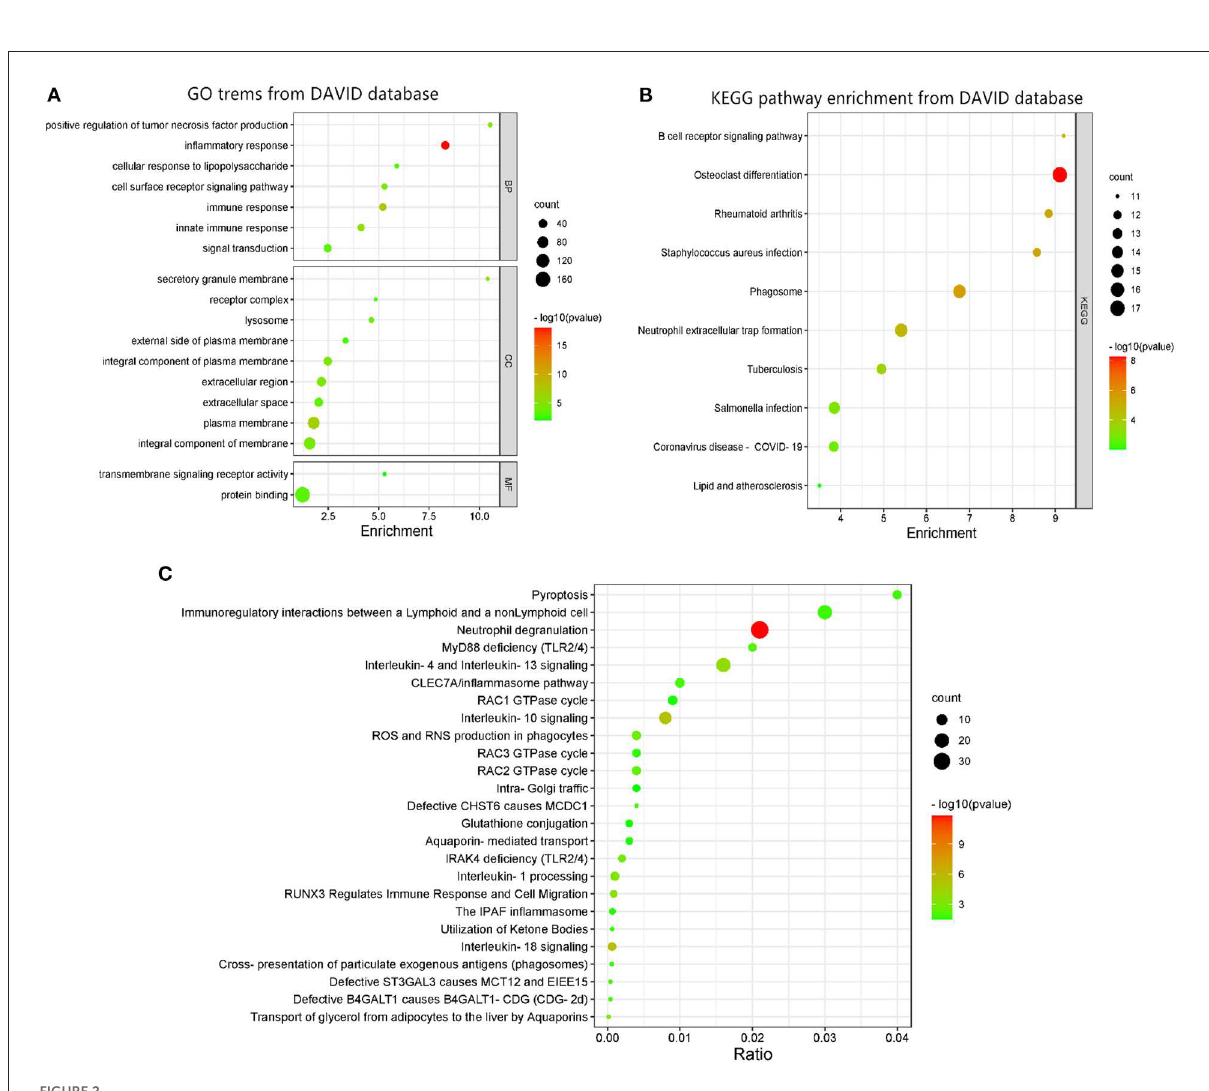
FIGURE2 GO terms and KEGG pathway enrichment: (A) GO term enrichment for DEGs. (B) KEGG pathway of DEGs. (C) Functional and pathway enrichment of DEGs from REACTOME database. Dot sizes represent counts of enriched DEGs, and dot colors represent negative Log10- p